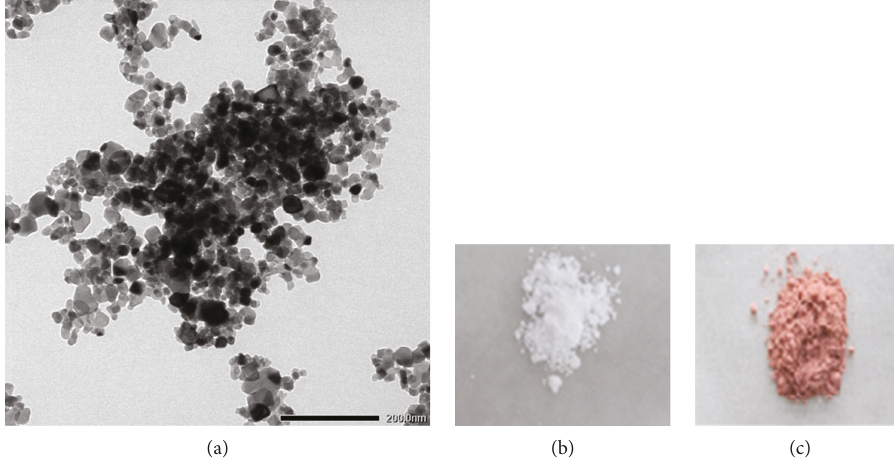
Figure 2: (a) TEM image of 0.75 Ag-TiO